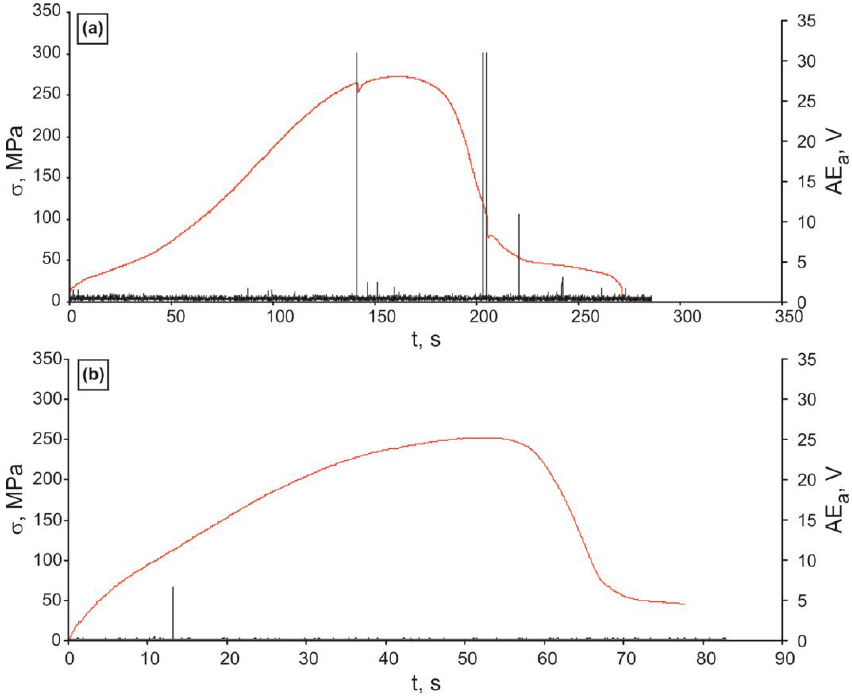
Figure 14. Combined AE diagrams and stress – strain curves for composite sample after rotary forging to a diameter of ( a ) 5 mm ( e = 2.77) and ( b ) 2.5 mm ( e = 4.16). As the composite sample’s diameter decreased to 2.5 mm, the number of high-amplitude signals decreased. At the same time, the AE intensity also strongly de- creased, which is explained, among other things, by the scale factor. Annealing of the composite samples with diameters of 5 and 2.5 mm at 180 and 300 ° С did not change the character of AE during tension compared to unannealed samples (Figures 15 and 16).